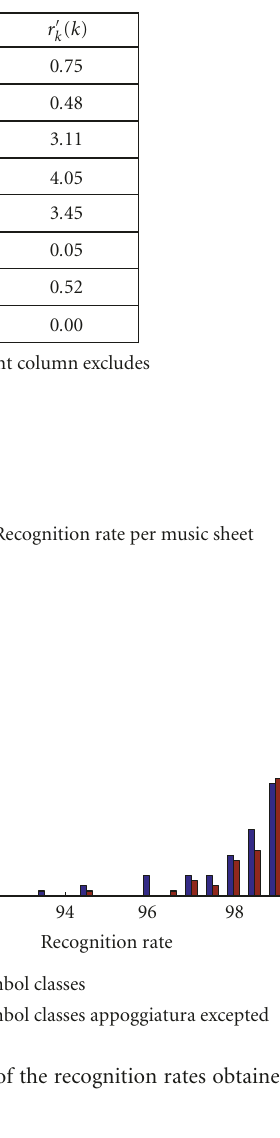
Table 5: Recognition rates per class.